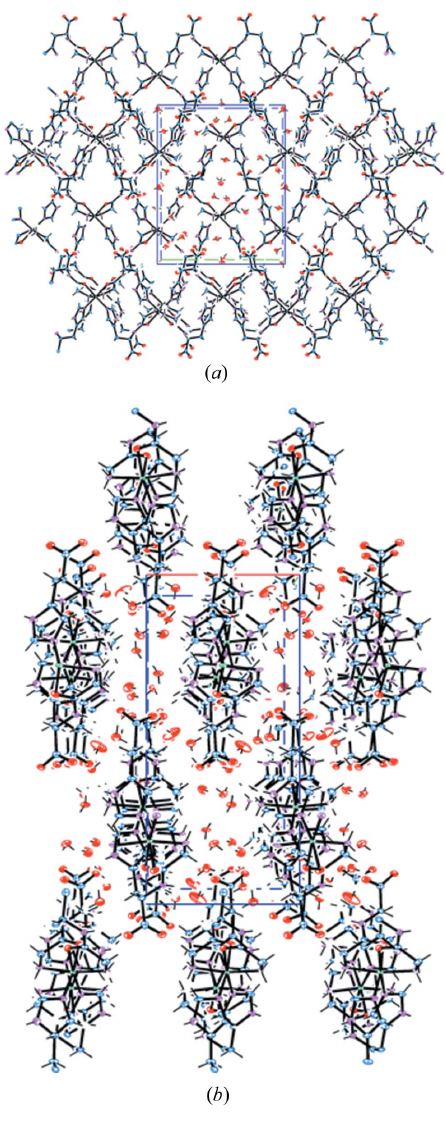
Figure 1 1D polymers extending down the b axis (into the page) and ( a ) hydrogen bonding of the hydrates in the channels formed between them. ( b ) A perpendicular view clearly indicating water channels. Carbon is shown in black, nitrogen is shown in blue, oxygen is shown in red and nickel is shown in